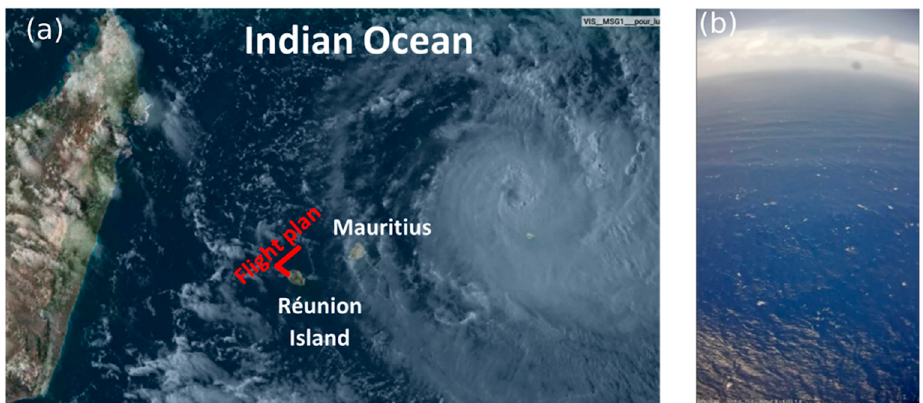
Figure 17. ( a ) Satellite image of TC JOANINHA on 25 March 2019 in the vicinity of Mauritius and Réunion Island. ( b ) picture from the BOREAL on-board camera showing the ocean sea-state and the TC on the horizon. Sources: ( a ) MSG satellite; ( b ) Christophe Mazel